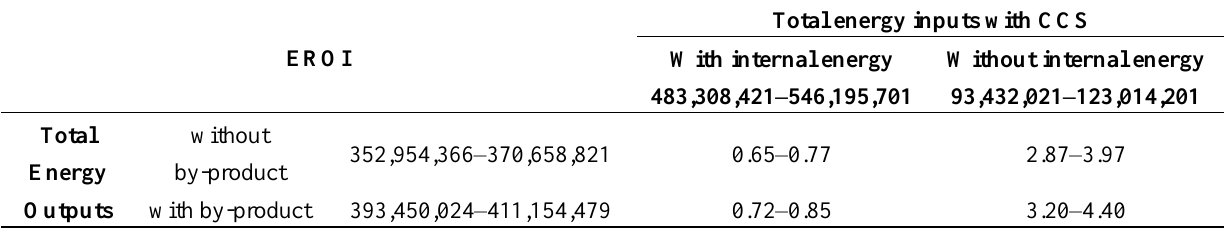
Table 7. EROI of the Shenhua DCL project with